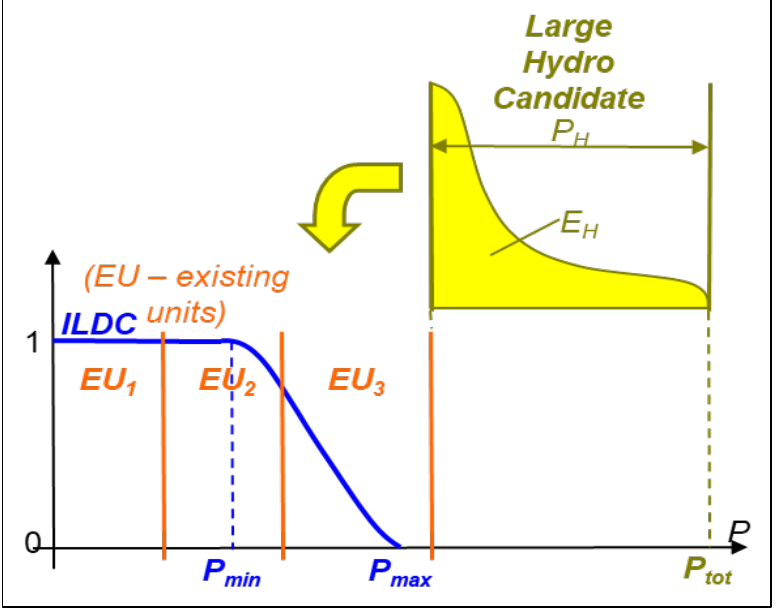
Figure 10. Fitting a large hydro plant in the LDC.